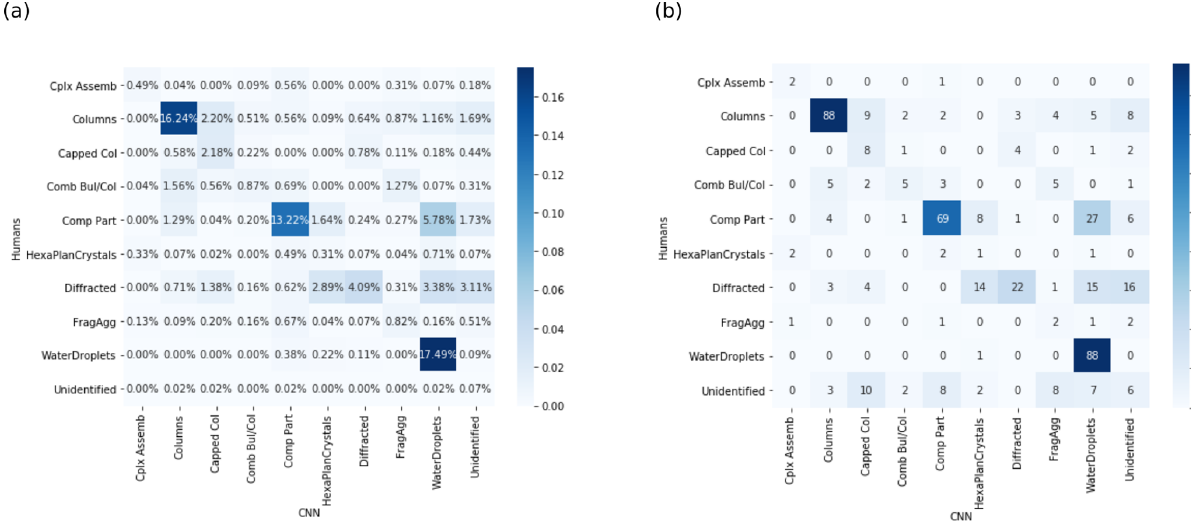
Figure 6. Comparison between human and CNN results. (a) Confusion matrix (2DS); identification threshold at 50% for the CNN results. (b) Mean confusion matrix (PIP) in numbers; identification threshold at 50% for the CNN and human results. Overall, the agreement between them is 58 . 2%. The expected porosity between CP and RA and between FA and RA seems to appear and is investigated in Fig. A3. Every one of the 40 images considered unidentified by the algorithm shows its highest score in the CP